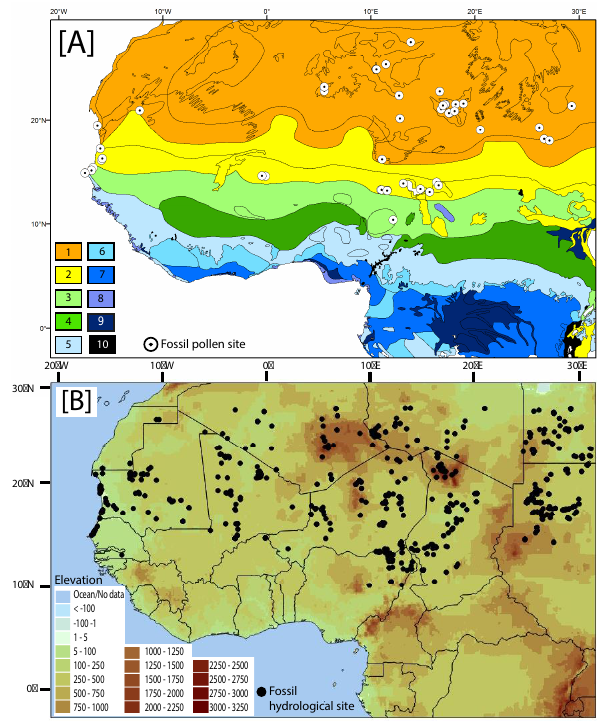
Fig. 1. Location of West African sites over the study area. (A) Fos- sil pollen sites (white circles) extracted from the African Pollen Database (http://apd.sedoo.fr/apd/accueil.htm) with the distribu- tion of modern phytogeographical zones and associated biomes (adapted from White, 1983) as follows: desert steppe (1), Sa- hel acacia wooded grassland (2), Sudanian undifferentiated wood- land (3), Sudanian Isoberlina woodland (4), mosaic of lowland rain forest and secondary grassland (5), Guineo–Congolian rain forest dry types (6), Guineo–Congolian rain forest wet types (7), mangrove (8), edaphic vegetation (9), and undiferentiated montane vegetation (10). (B) Fossil hydrological sites (black circles) from Lézine et al. (2011a) on elevation (ma.s.l.) background. It is worth noting that modern phytogeographical zones of Guineo–Congolian forests and Sudanian woodlands and savannas are far more south than the southernmost hydrological and pollen fossil